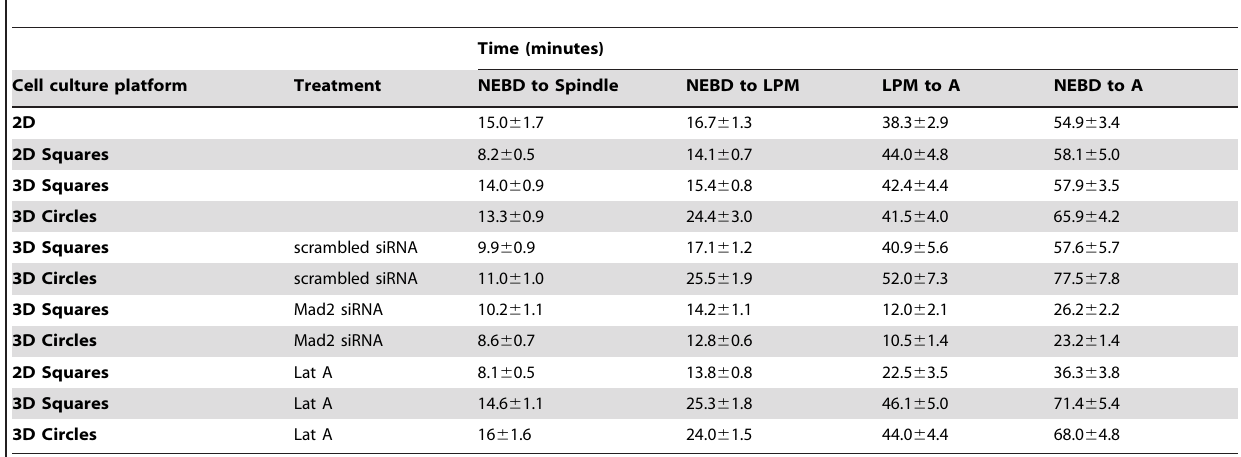
Table 1. Analysis of mitotic timings in single cells cultured on different cell culture